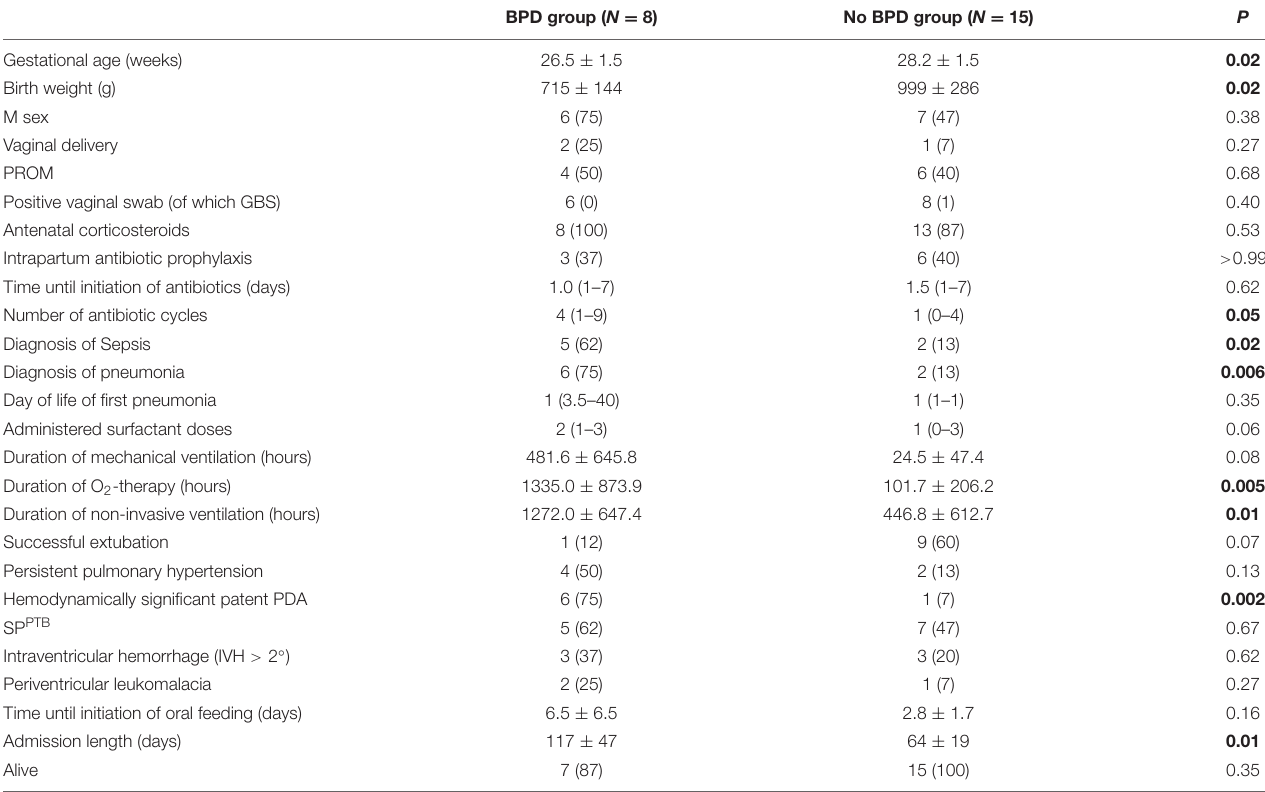
TABLE 2 | Demographics and clinical characteristics of patients with and without diagnosis of